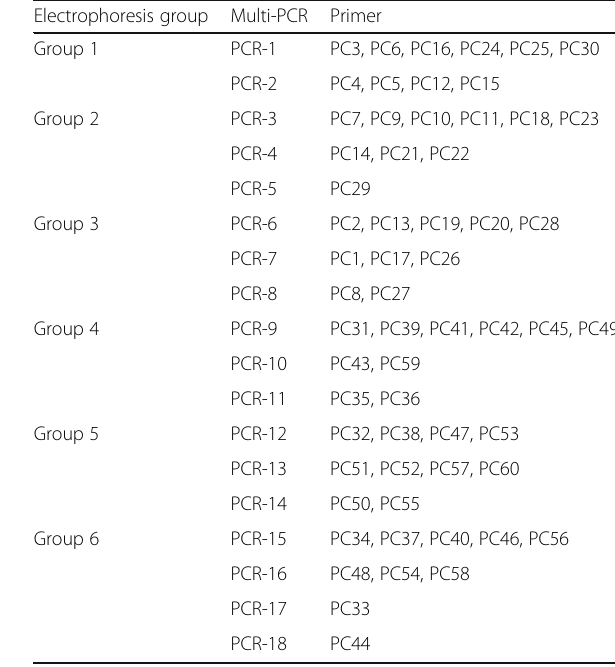
Table 3 Combinatorial information for